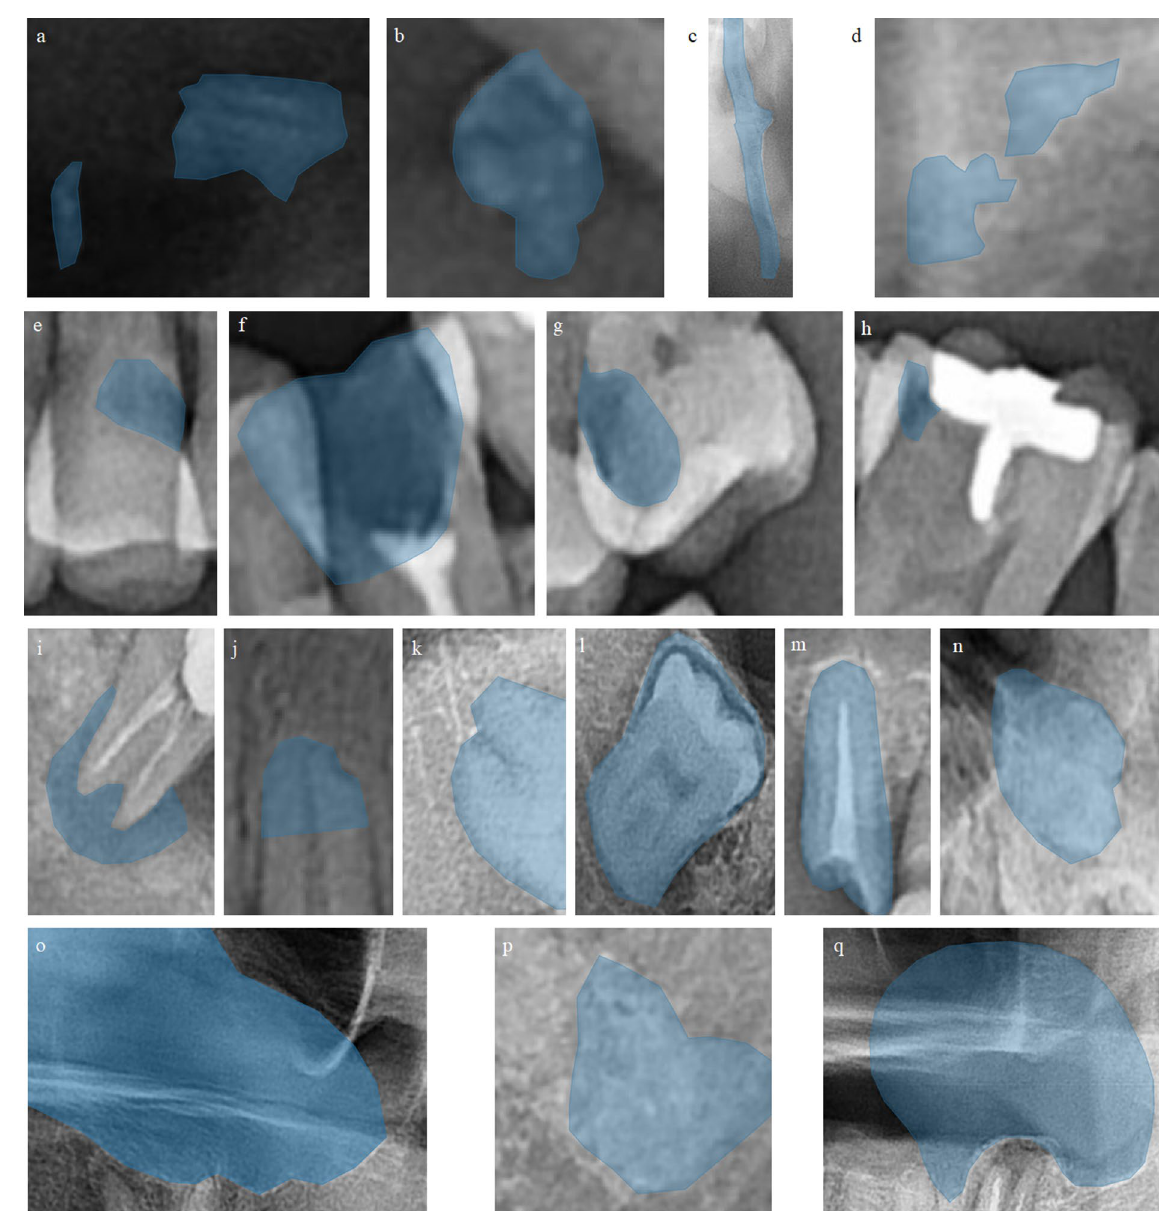
Figure 1. Examples of labeled 17 dental anomalies. (a) Calcified carotid atherosclerotic plaque, (b) lymph node calcification, (c) ossification of stylohyoid ligament, (d) tonsillar calcification, (e) cervical caries or